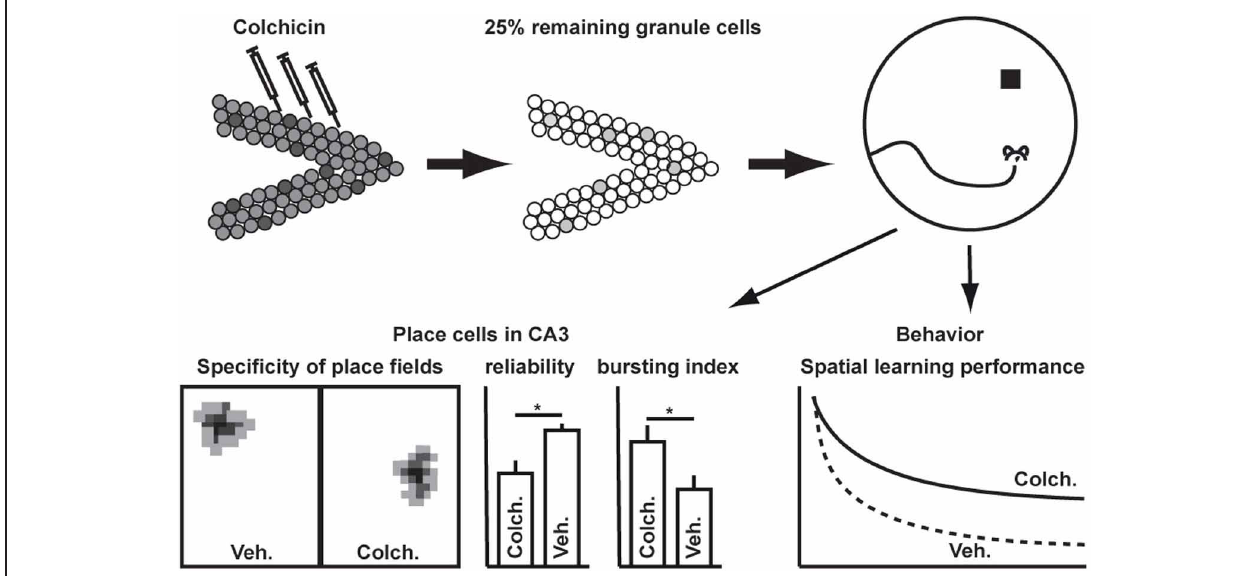
FIGURE 1 | Spatial specificity of place cells in CA3 does not depend on input from the dentate gyrus [as shown by McNaughton et al. (1989)]. Ablation of dentate granule cells causes spatial learning deficits on the behavioral level and increases the bursting probability of pyramidal cells in CA3. ∗ p < 0 .